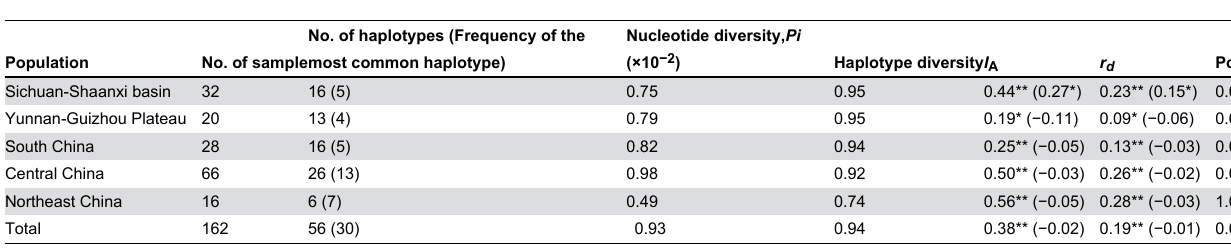
Table 2. Genetic variation patterns within populations.